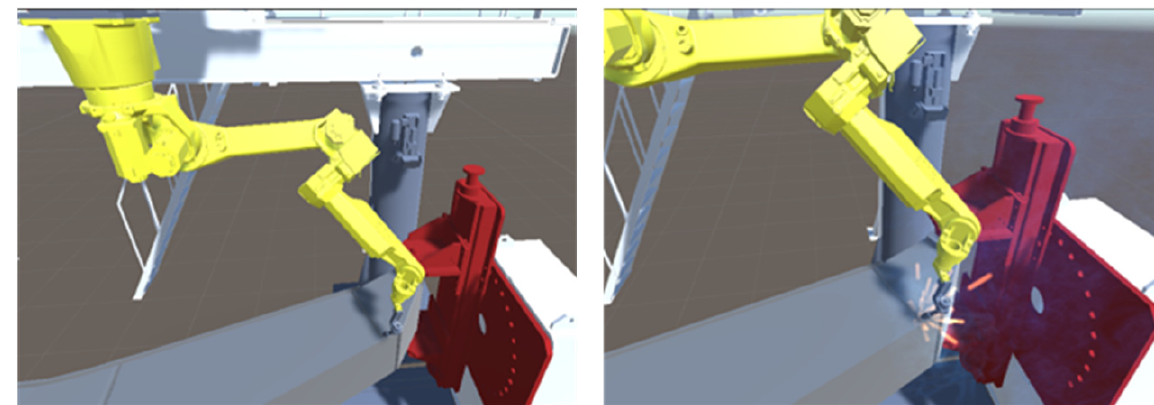
Figure 13. Screenshot of virtual welding experiment.